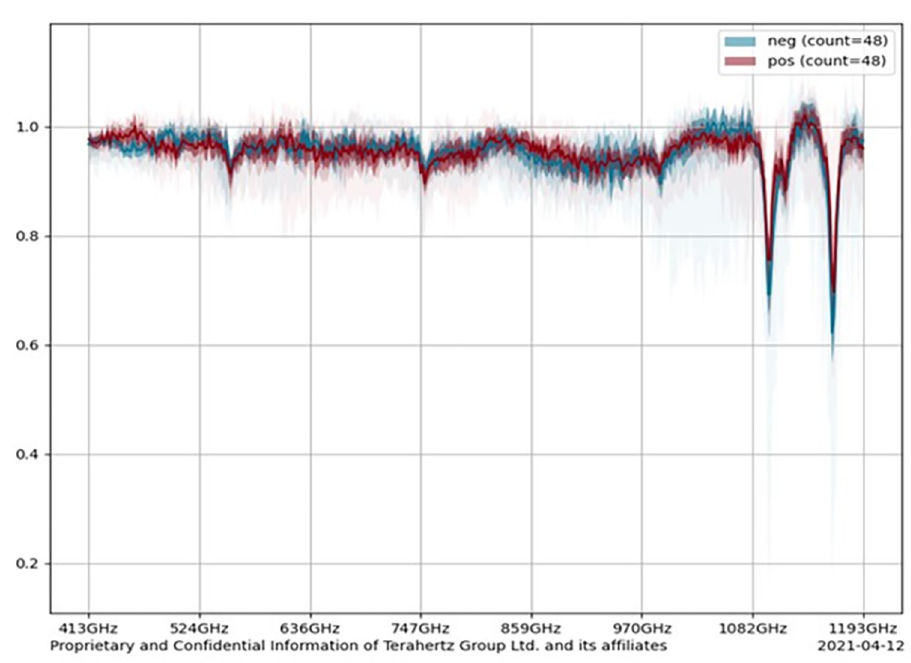
Fig 4. ROC curve for the entire